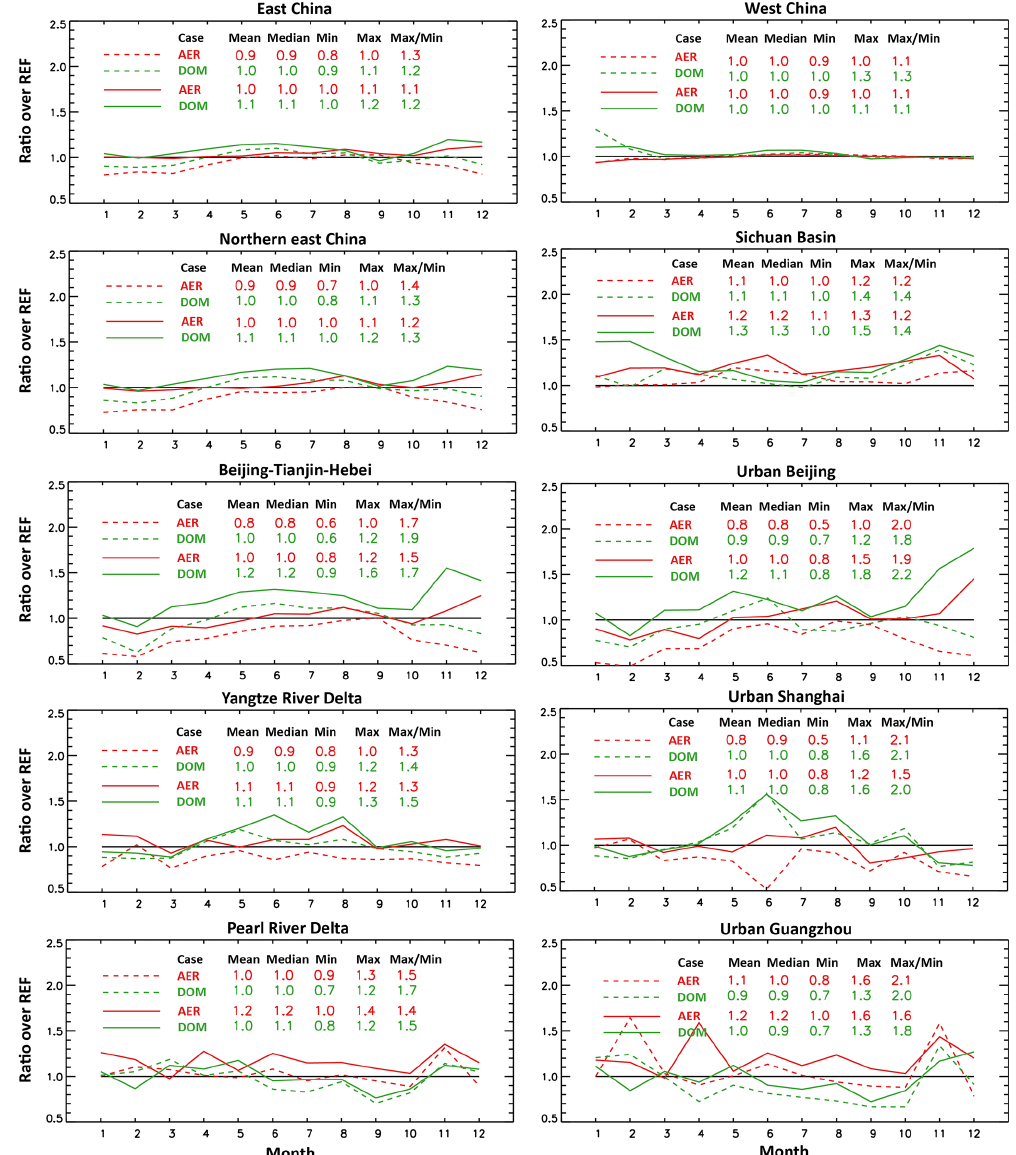
Figure 9. Ratios of cases AER and DOM to case REF for regional mean NO 2 VCDs in each month of 2012. Regions are defined in Fig. 1a. For cases AER and DOM, data can be sampled from pixels valid in respective retrieval approaches (dotted lines) or valid in case REF (solid lines). Also shown are some statistical